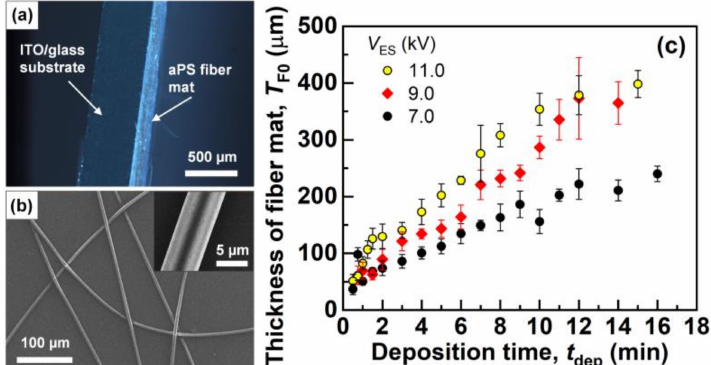
Figure 2. ( a ) Dark-field cross-sectional optical microscopy image of the electrospun aPS fiber mat produced with V ES = 9.0 kV and t dep = 9 min. ( b ) An FESEM image of the individual aPS fibers. The inset shows an enlarged FESEM image of a single fiber. ( c ) The average thickness of each fiber mat. The error bars represent standard